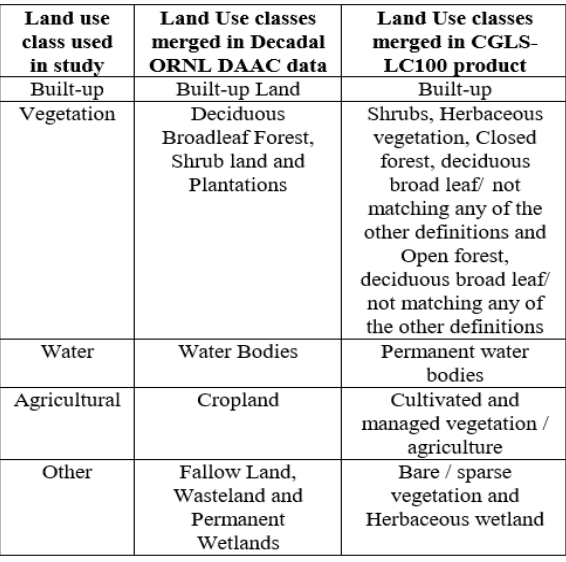
Landscape metrics help studying in quantification of spatial